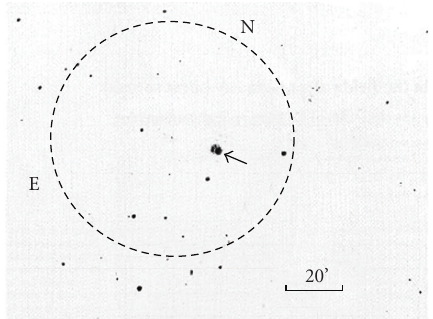
Figure 7: The OT inside the error box of GRB910219.